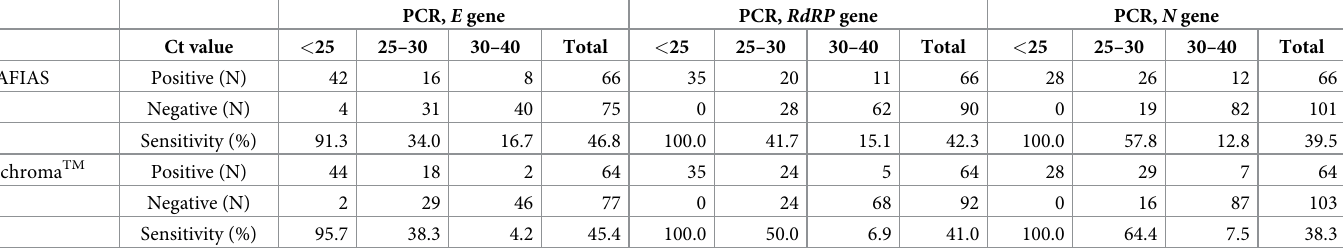
Table 1. Diagnostic sensitivity of the AFIAS COVID-19 Ag and the ichroma TM COVID-19 Ag, the rapid point-of-care SARS-CoV-2 antigen assays compared to real-time RT-PCR assay for SARS-CoV-2 detection.